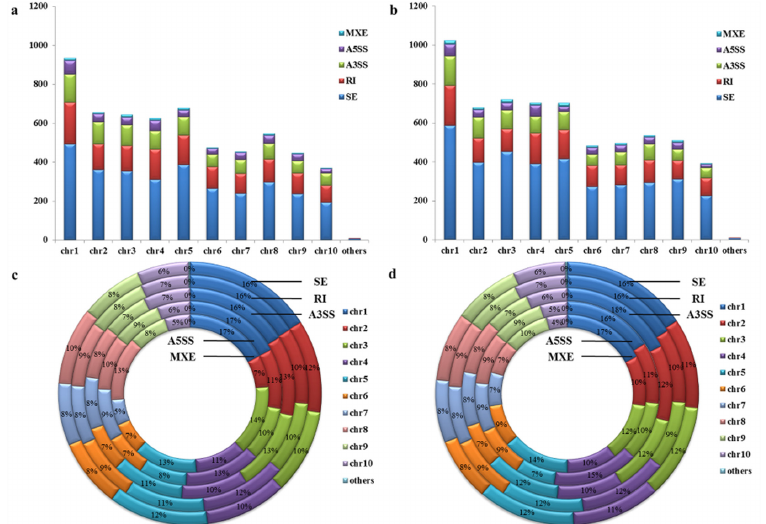
Figure 1. Overview of alternative splicing events in maize infected with RBSDV. ( a )Distribution of various AS event modes from chromosome 1 to 10 in maize infected with RBSDV at 1.5 DAI; ( b ) distribution of various AS event modes from chromosome 1 to 10 in maize infected with RBSDV at 3.0 DAI; ( c ) distribution of different modes of genes from chromosome 1 to 10 in maize infected with RBSDV at 1.5 DAI; ( d ) distribution of different gene modes from chromosome 1 to 10 in maize infected with RBSDV at 3.0 DAI.